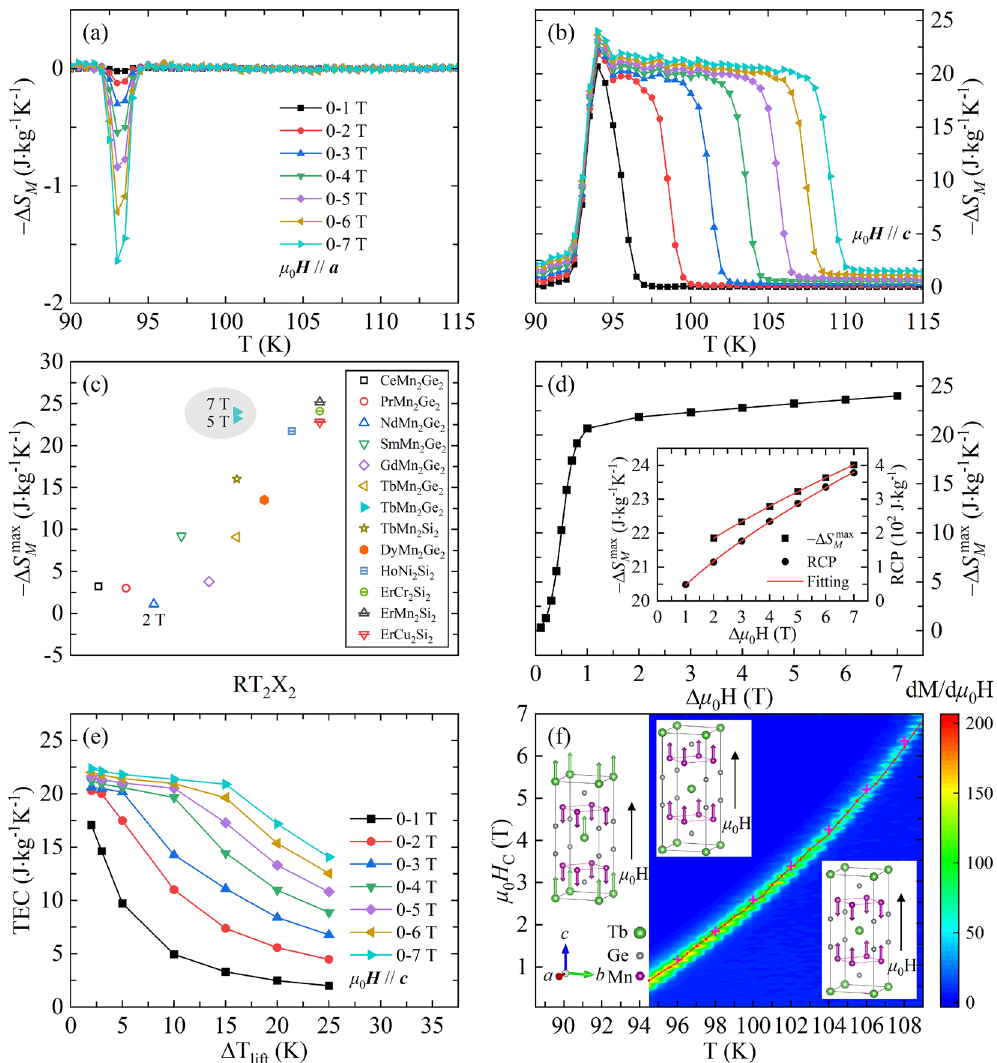
Figure 4. Temperature dependence of − (cid:31) S M for TbMn 2 Ge 2 single crystal calculated from the isothermal initial magnetization along ( a ) a and ( b ) c axes. ( c ) Bubble chart of − (cid:31) S max M for the selected RT 2 X 2 compounds. The solid and open symbols represent single crystal and polycrystal samples, respectively. The samples are arranged from left to right according to the atomic number of the rare earth elements in ascending order. The data in the dash area indicate our results. The Δ μ 0 H is 5 T if not specifically indicated. ( d ) The Δ μ 0 H dependence of − (cid:31) S max M for μ 0 H // c . The inset shows the field-dependent parameters of − (cid:31) S max M and RCP for μ 0 H // c with larger magnetic field, and the red curves show the nonlinear fitting based on a power law. ( e ) The TEC as a function of ΔT lift for the field along c axis. ( f ) Magnetic phase diagram of TbMn 2 Ge 2 single crystal for μ 0 H // c . The red balls denote the μ 0 H C obtained from the isothermal curves transition, and the purple crosses indicate the ones from the magnetostriction results. The insets show the moments of Mn and Tb sublattices at specific magnetic field and temperature